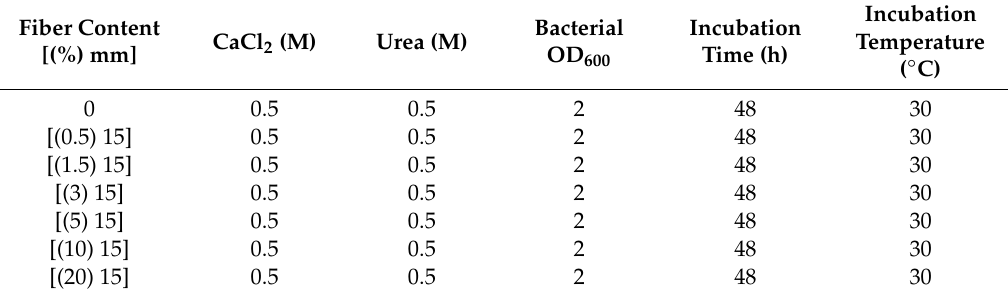
Table 2. Testing conditions for CaCO 3 precipitation with jute fibers (content).